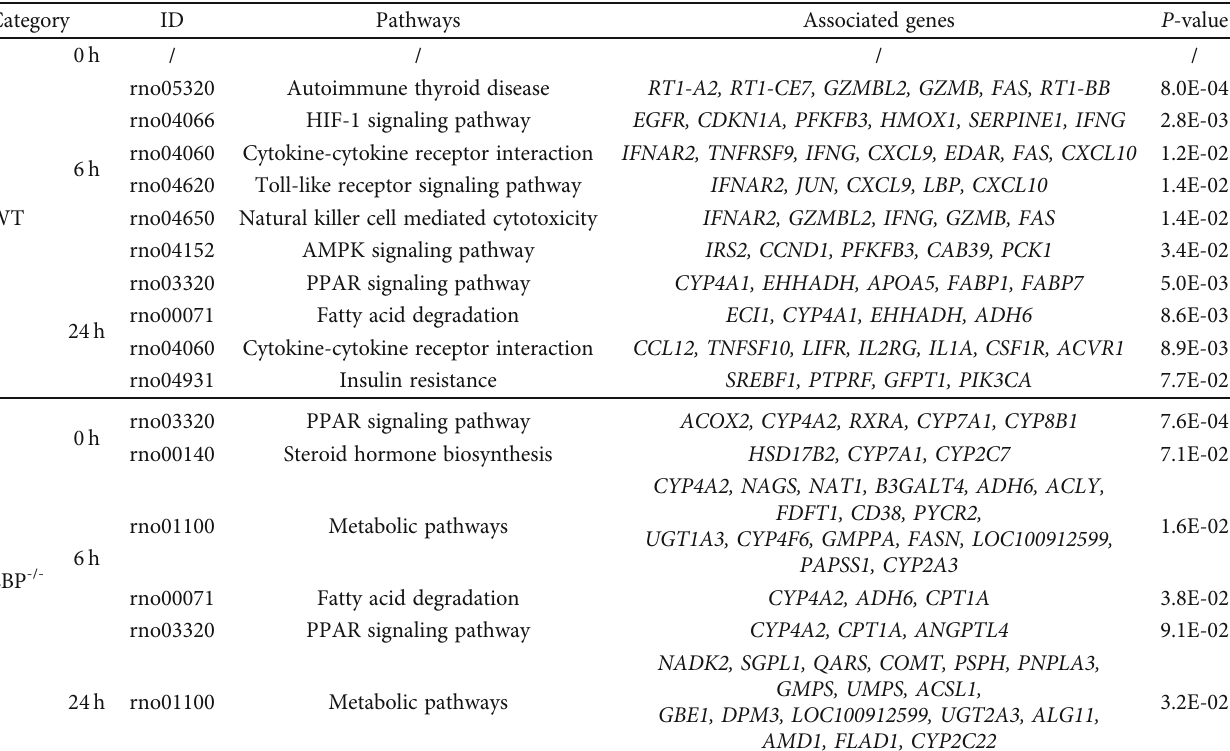
74 : 68 ± 23 : 33 % at 6h (vs. LBP-de fi cient rats: 96 : 28 ± 4 : 52 % , P < 0 : 05 ) and then increased at 24h ( 79 : 97 ± 20 : 94 % ,